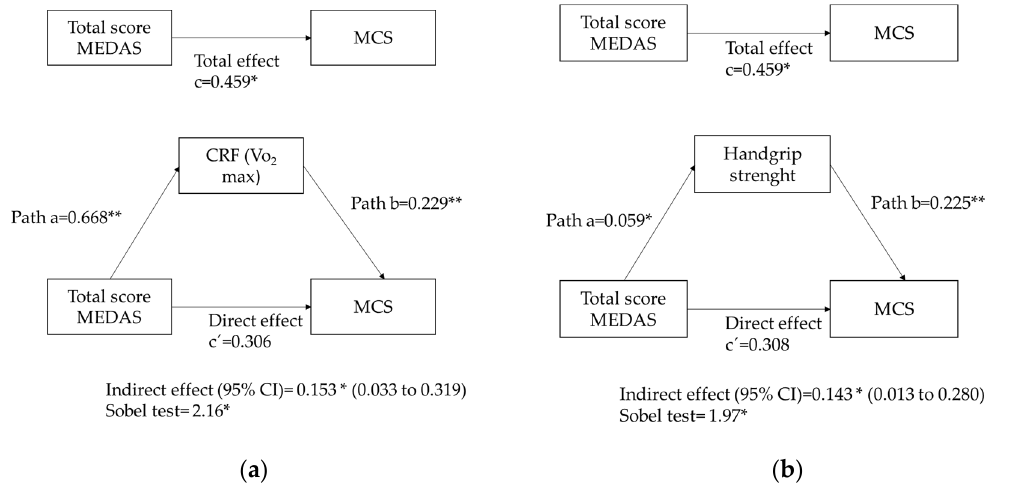
Figure 1. ( a ) Cardiorespiratory fitness CRF (VO2 max estimate) and ( b ) handgrip strength mediation models of the relationship between the Mediterranean Diet Adherence Screener (MEDAS) and mental HRQoL (MCS), controlling for age, sex, and socioeconomic status(SES). * p ≤ 0.05; ** p < 0.001.